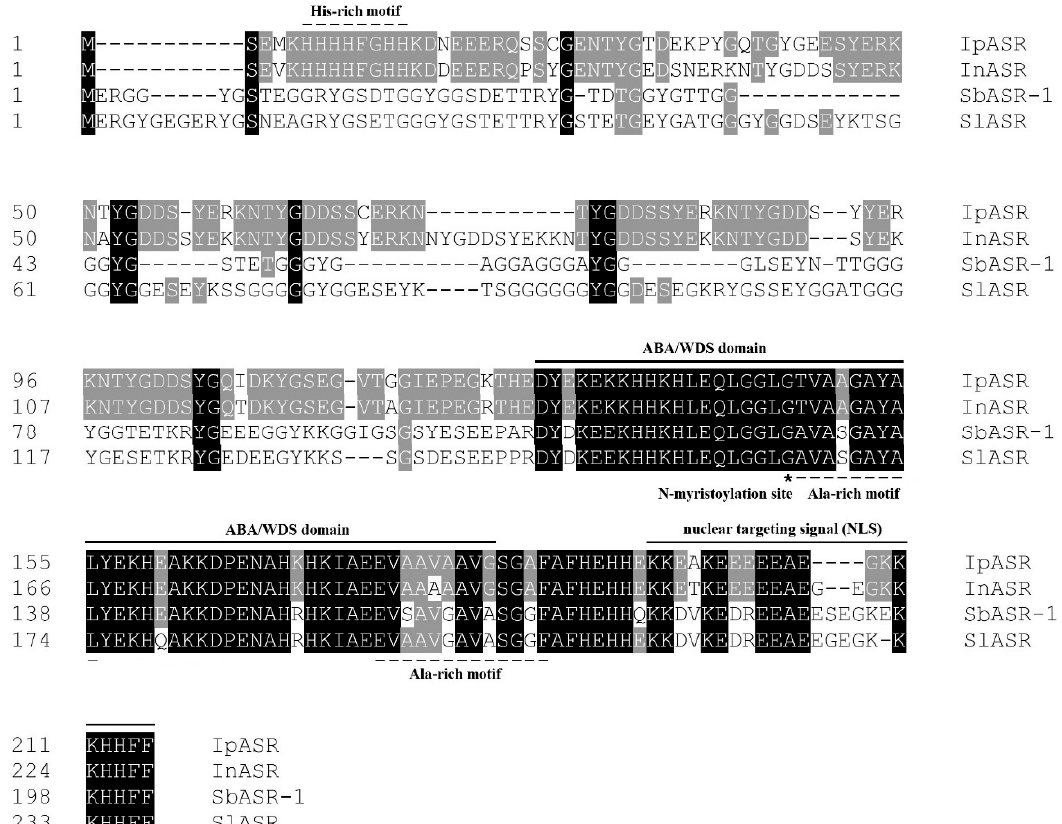
Figure 1. Comparison of IpASR from I. pes-caprae with abscisic acid, stress and ripening (ASR) proteins from other plant species; I. nil InASR (BAF46301.1), S. brachiata SbASR-1 (ACI15208.1), and S. liaotungensis SlASR (AGZ20206.1). The abscisic acid/water deficit stress (ABA/WDS) domain, one